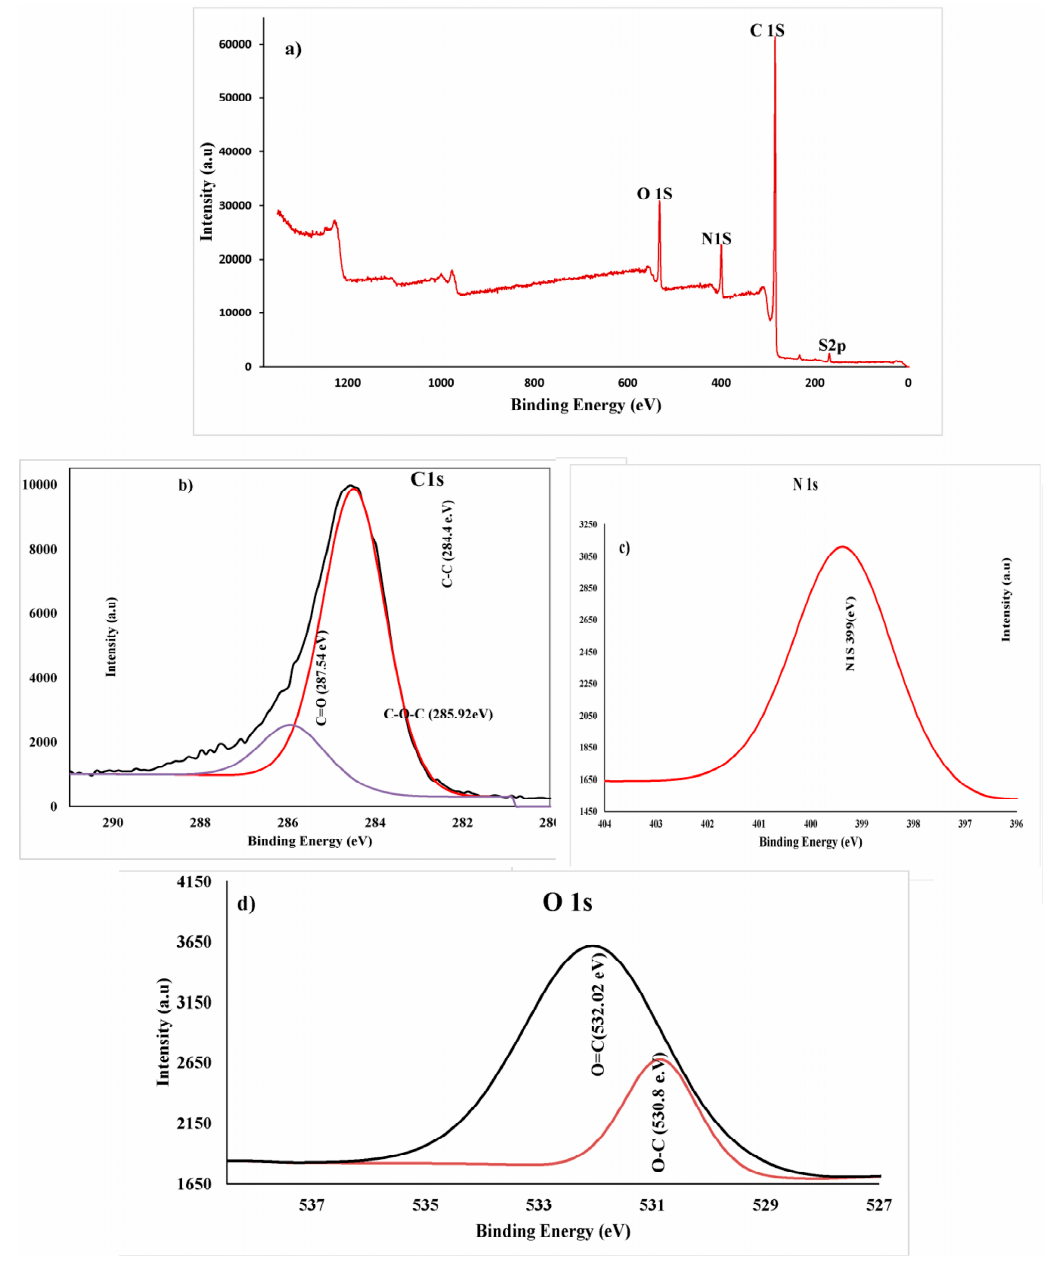
Figure 9. ( a ) XPS survey of PANI thin film on ITO, ( b ) C1 s spectra, ( c ) N1 s spectrum, and ( d ) O1 s spectra.